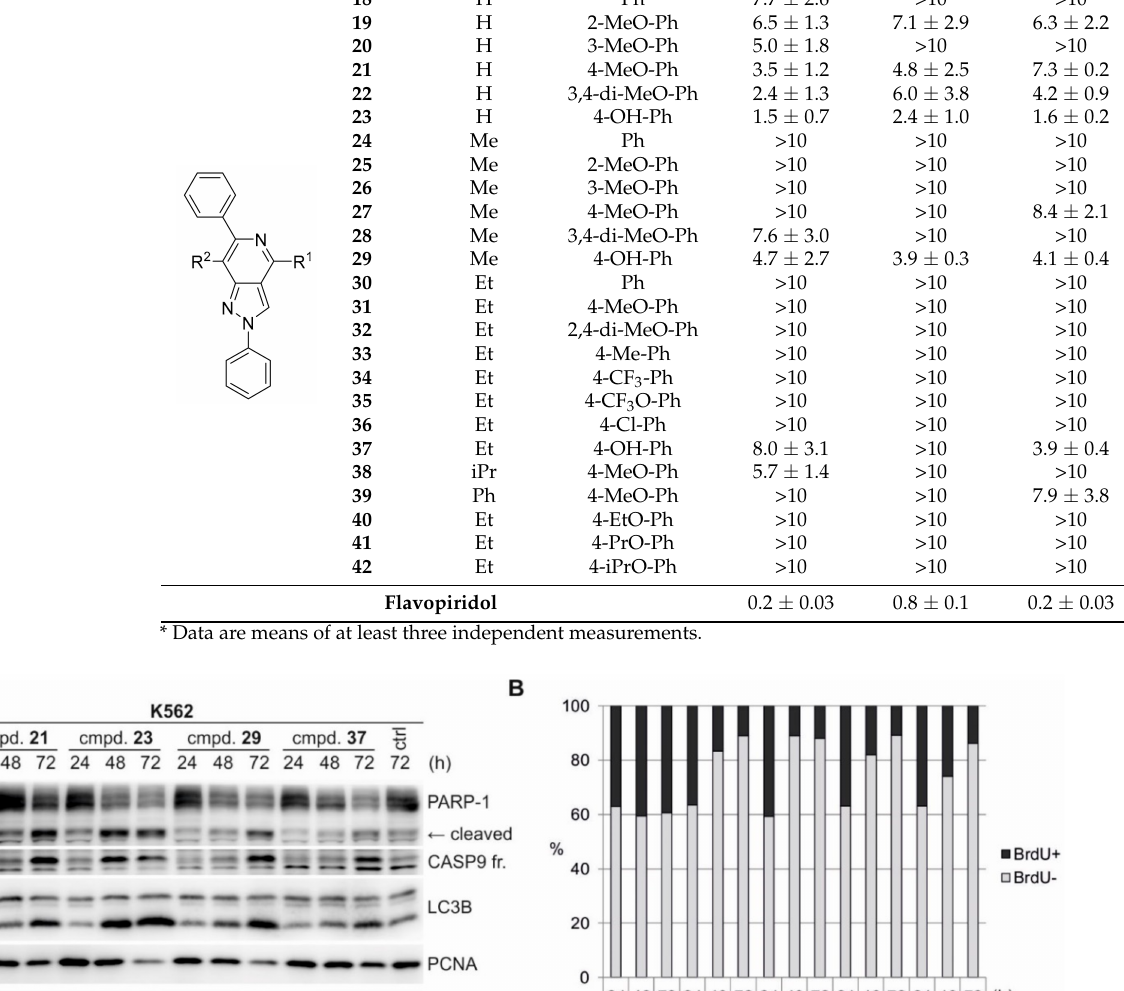
Table 1. In vitro antiproliferative activity of 2 H -pyrazolo[4,3- c ]pyridine derivatives 18 – 42 . Structure